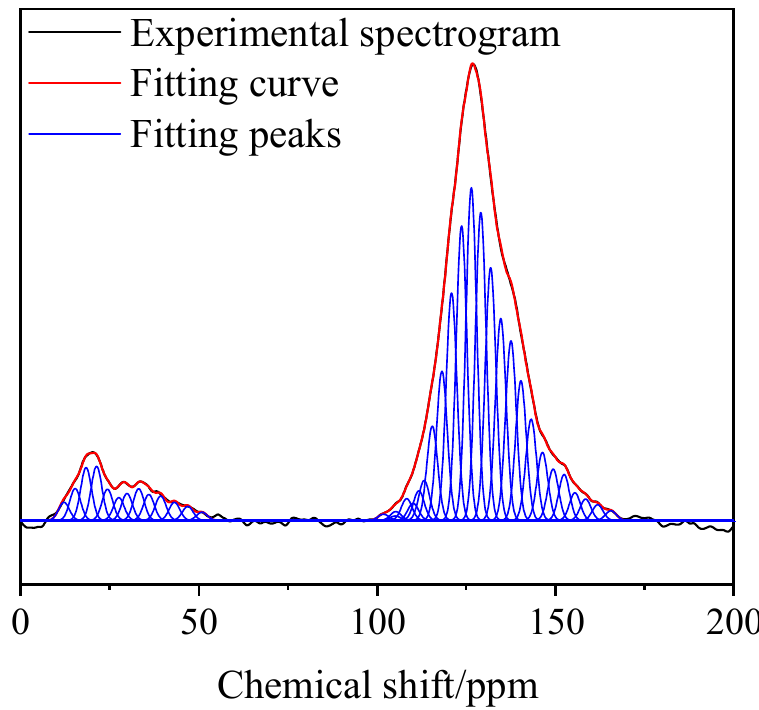
Figure 2. 13 C-NMR split-peak-fitting spectrum of gas coal. Table 3. Carbon structure attribution and proportion.